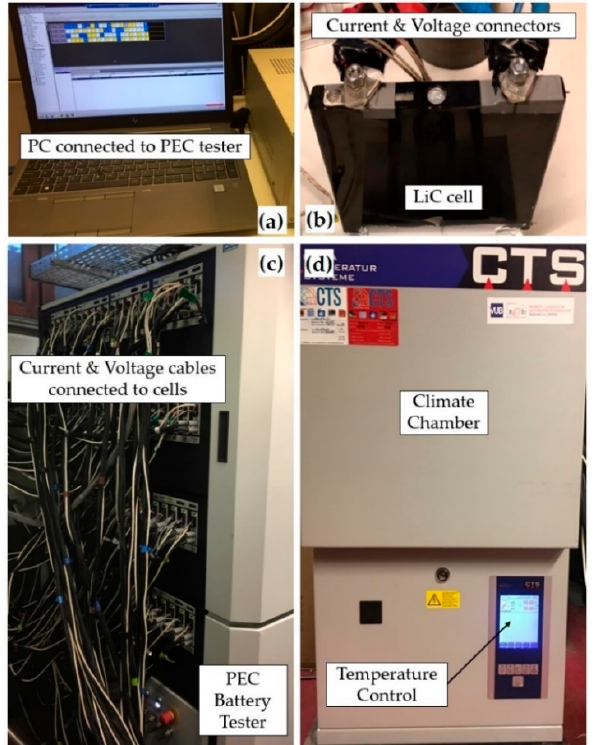
Figure 1. The experimental test bench: ( a ) computer connected to the PEC battery tester, ( b ) the LiC cell with connected current and voltage cables, ( c ) PEC battery tester with current and voltage cables connected to the LiC cells, ( d ) CTS climate chamber to control the ambient temperature for the tests. The temperatures used for the experiments range from − 30 ◦ C to +60 ◦